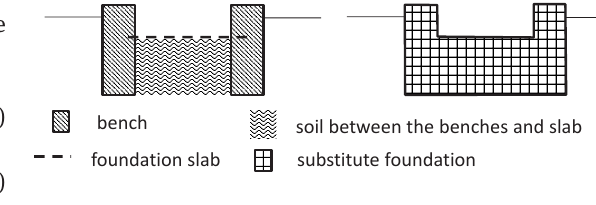
Figure 4: Proposed substitute foundation for benches, slab and soil between